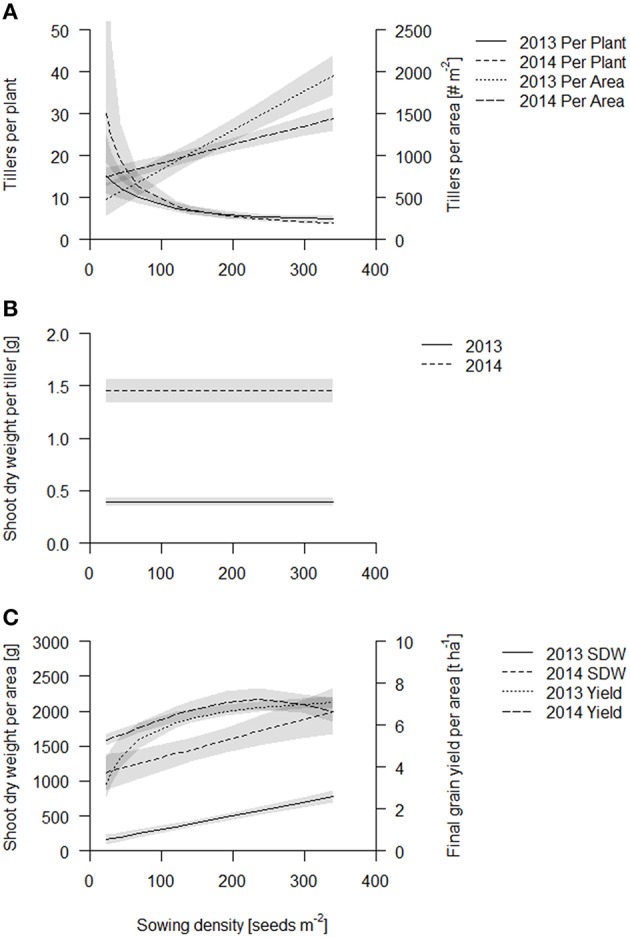
Aboveground traits of the coring events of Scarlett and Barke in 2013 (solid line) and 2014 (dashed line). Data are presented as best fits with 95% confidence interval (gray). For equations, R2 and p-values see Table S1. (A) Tillers per plant and tillers per area; (B) Shoot dry weight per tiller; (C) Shoot dry weight per area and final grain yield.